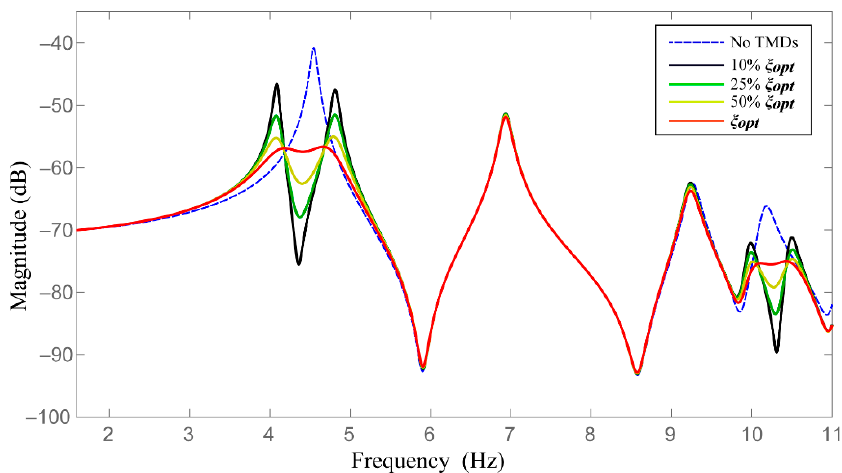
Figure 5. Influence of the damping of TMD1 on the FRF of the system. ξ = 10% ξ opt , 25% ξ opt , 50% ξ opt and ξ opt , respectively.